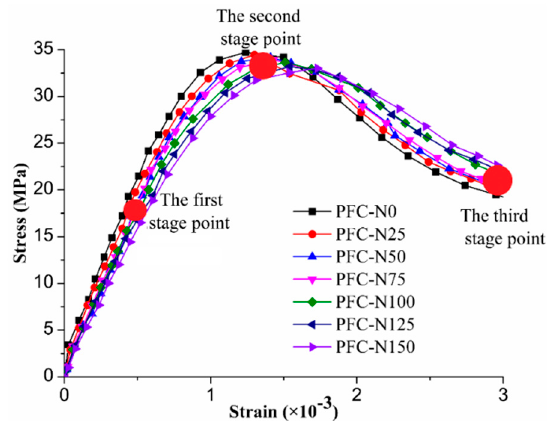
Figure 8. Stress–strain curve of concrete under freezing–thawing cycles by Particle Flow Code (PFC) stimulation.